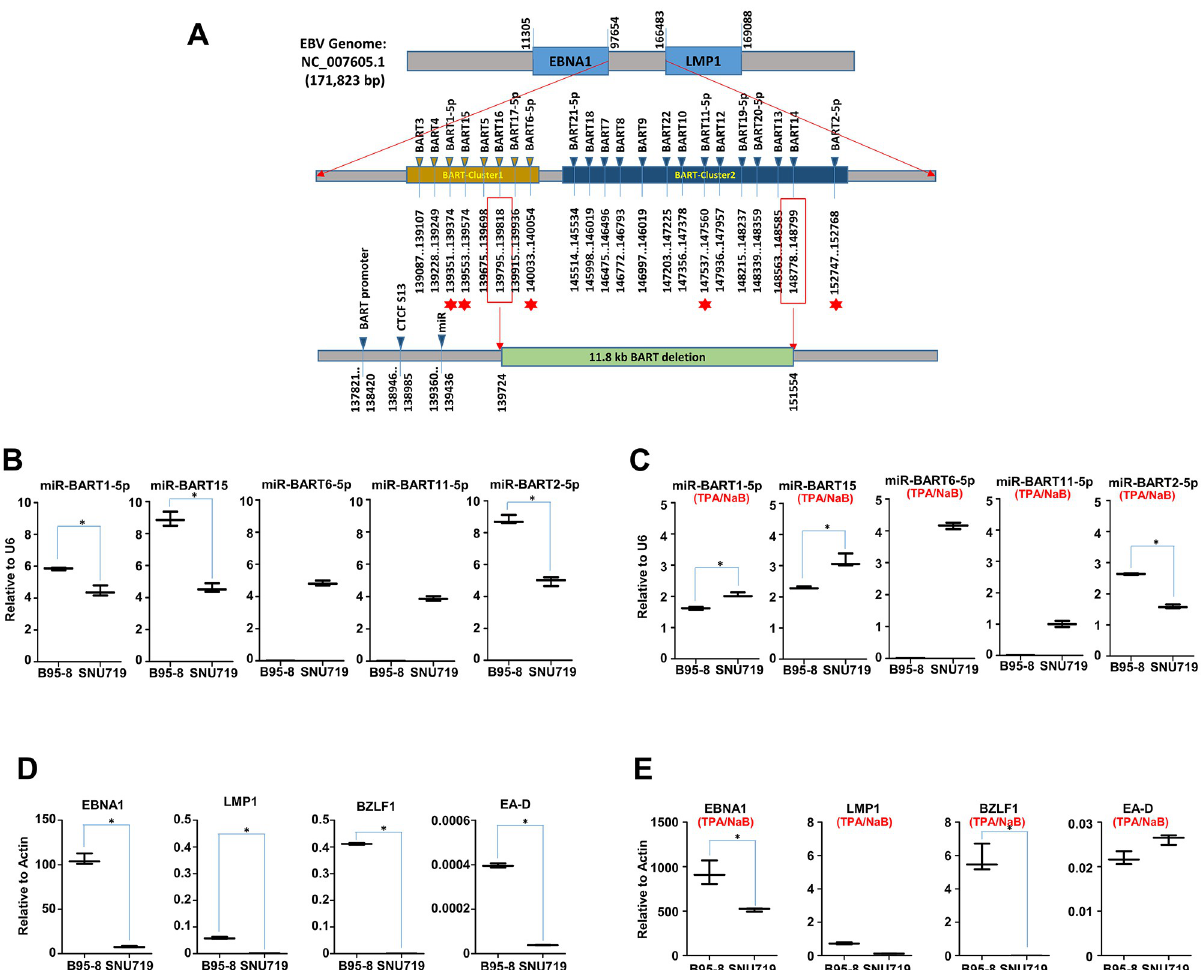
Fig 4. Analysis of BART miRNAs. A) Simple map of BART miRNAs in EBV BART miRNA cluster composed of BART cluster 1 and BART cluster 2. An 11.8 kb BART deletion was located downstream of CTCF binding site named as S13. Five BART miRNAs (BART1-5p, BART15, BART6-5p, BART11-5p, and BART2-5p) were selected to investigate expression patterns of BART miRNAs in B95-8 and SNU719 cells. B) Comparison of expression patterns of the selected five BART miRNAs between uninduced B95-8 and SNU719 cells. Due to the absence of miR BART6-5p and miR BART11-5p in B95-8 cells, their expression was not detectable in B95-8 cells. Expression of each miRNA was normalized with that of U6 expression. C) Comparison of expression patterns of the selected five BART miRNAs between induced B95-8 and SNU719 cells. D) Comparison of expression patterns of the selected EBV genes between uninduced B95-8 and SNU719 cells. Expression of each EBV gene was normalized with that of actin expression. E) Comparison of expression patterns of the selected EBV genes between induced B95-8 and SNU719 cells. Statistical analysis were performed using paired t test. In all panels, experiments were independently repeated two times, and data are represented as mean ± SD.